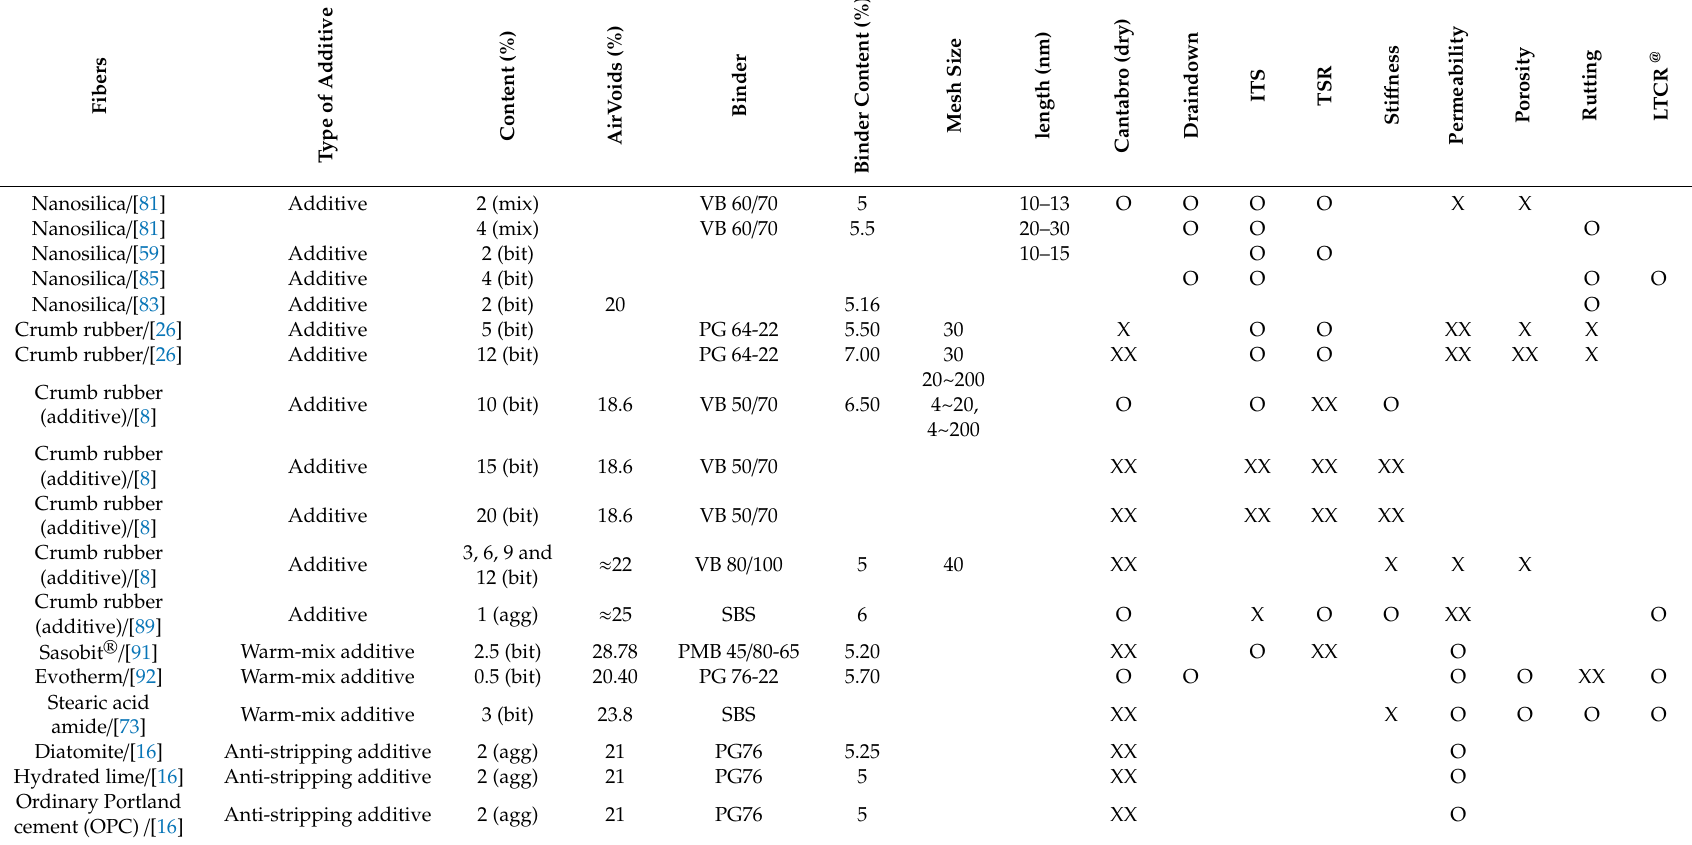
Table 2. Comparison of performance of additives in